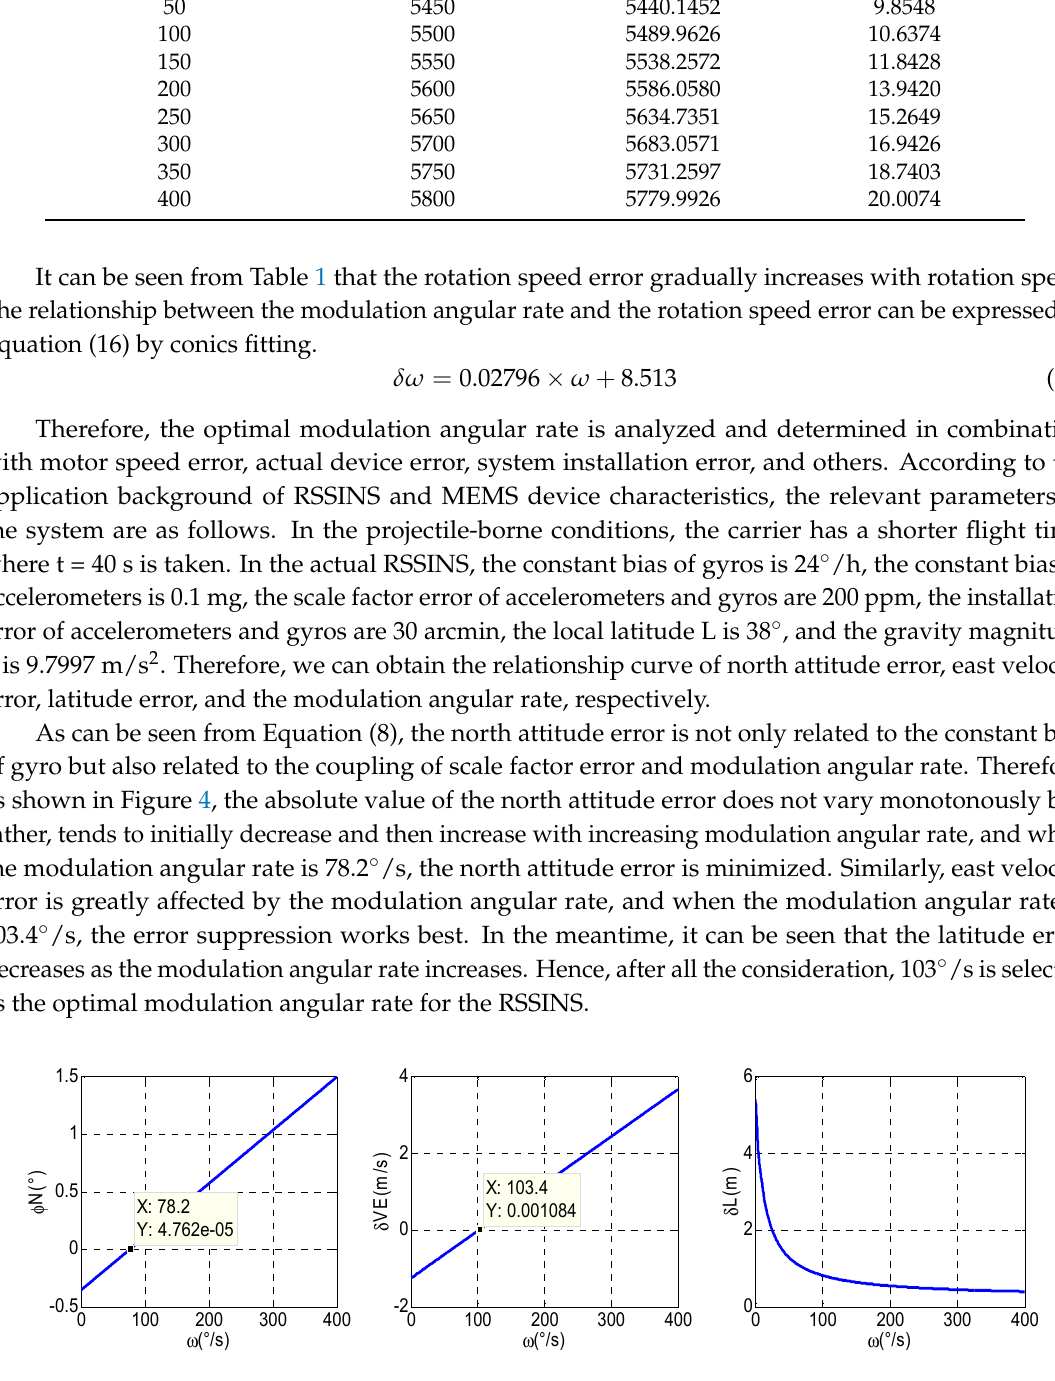
Table 1. Theoretical and practical rotation angular rate data.